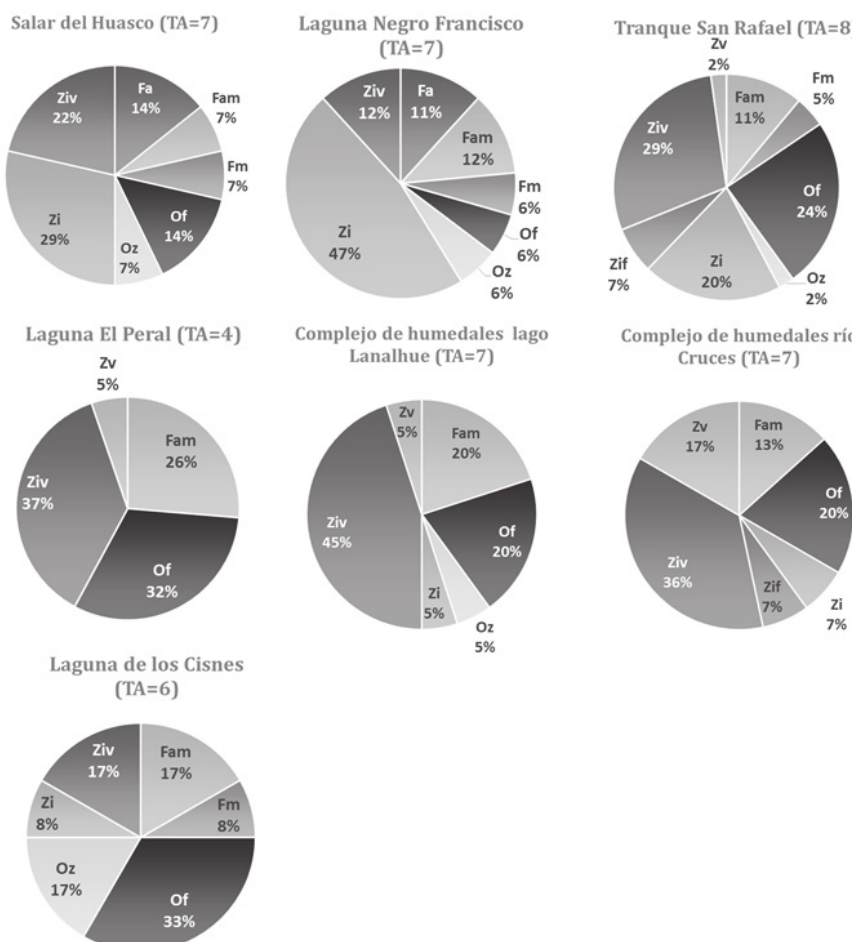
Figure 4. Feeding types (TA) of the species in the waterbird assemblages of seven inland wetlands in Chile. Z= Zoophagous (i= principally invertebrates; v= principally vertebrates). F=Phytophagous (a= prin- cipally algae; m= principally macrophytes). O= Omnivorous (f= principally phytophagous; z= principally zoophagous) (Martínez